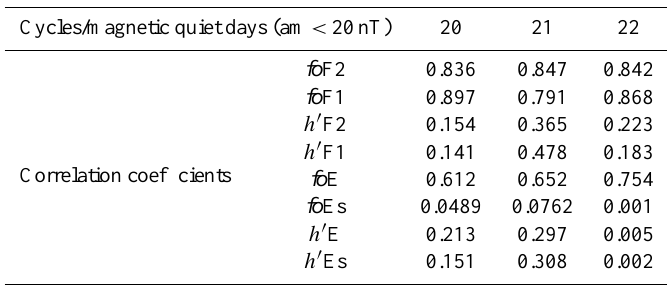
Table 2. Correlation coefficients between the ionospheric parameters and the sunspot number Rz during magnetically quiet days (am < 20nT).